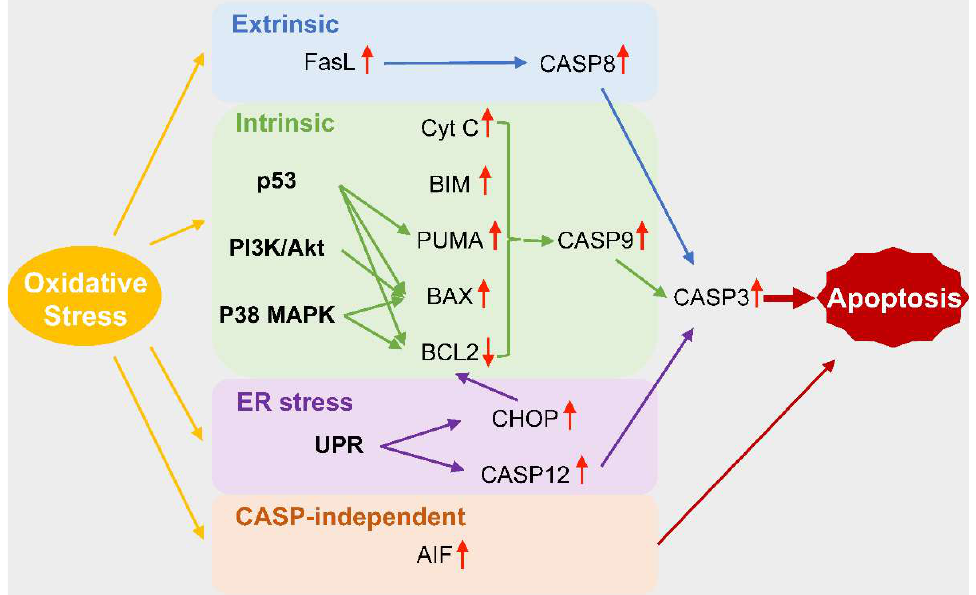
Figure 2. Molecular mechanisms for oxidative stress-triggered podocyte apoptosis. Oxidative stress